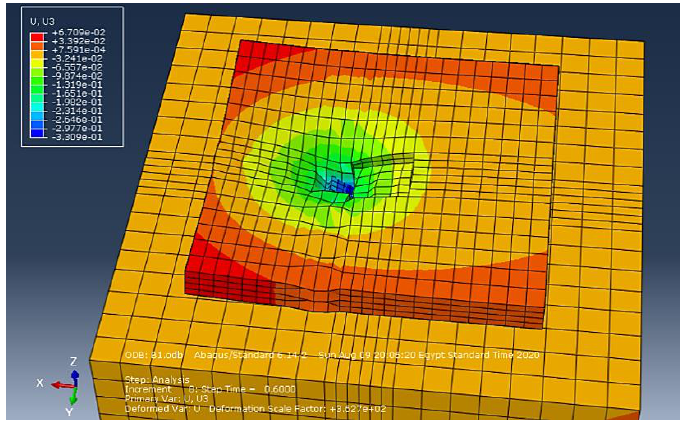
Figure 12. Shape of deflection. Table 14. Comparison between max load and deflection results of the nineteen tested specimens for patching analytically.